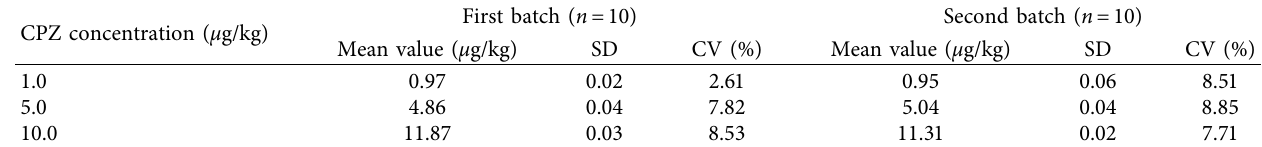
Table 2: CPZ detection by nano-TRFIA.